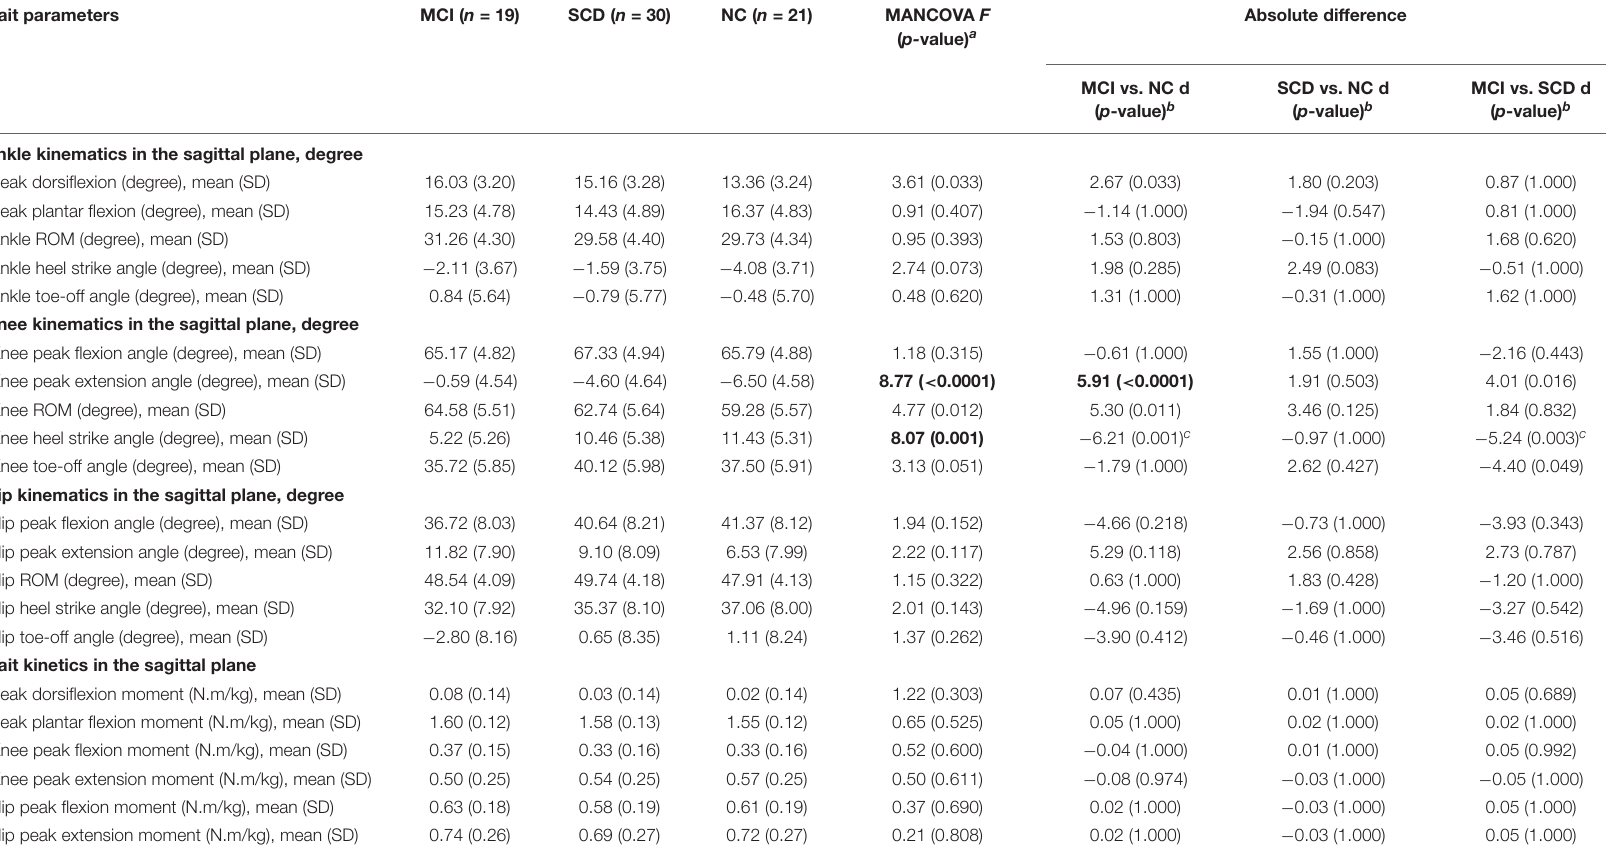
TABLE 3 | Comparison of gait kinematic and kinetic parameters on the right side among the three groups (MANCOVA). Gait parameters